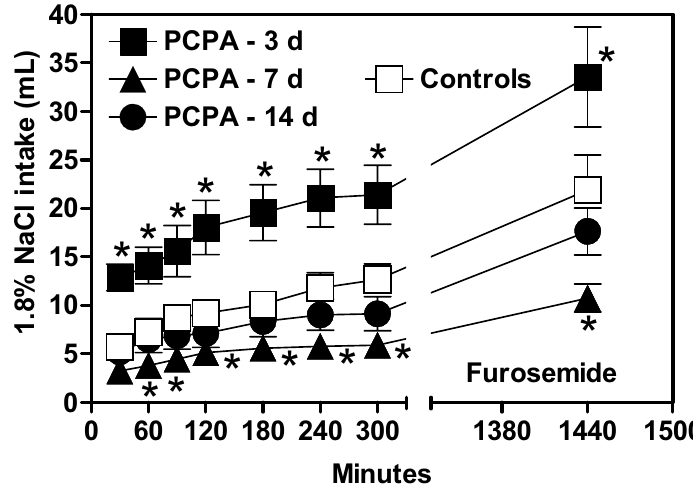
Fig. 2 – Chronic effect of treatment with p-chlorophenylalanine (PCPA, 300 mg/kg, ip , for 2 days), 3, 7 and 14 days after the first injection, on the natriorexi- genic response induced by sodium depletion mediated by furosemide (20 mg/kg, sc , 24 h before beginning of experiment). Mean values represent cumulative 1.8% NaCl intake from 30 min up to 24 h. Data are reported as means ± SE. ∗ P < 0 . 05 compared to